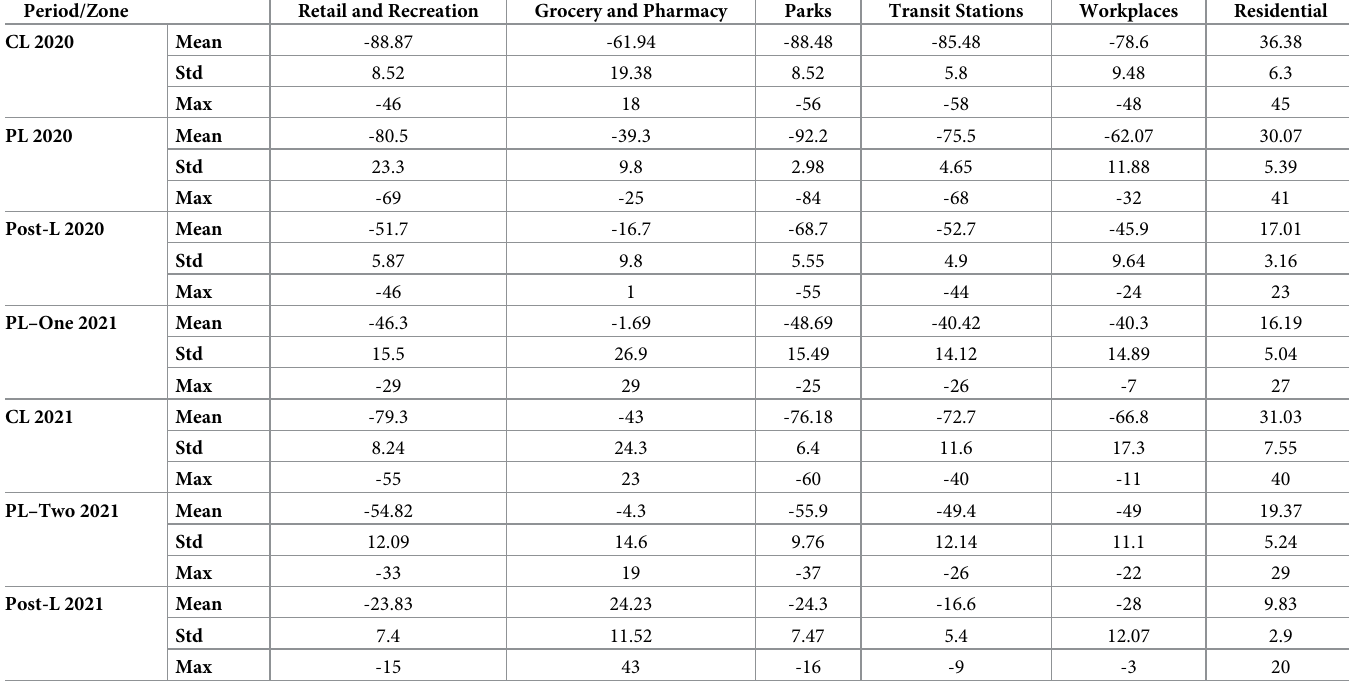
Table 2. Descriptive statistics of the changes in mobility (in %) from baseline during various lockdown phases in both waves in Chennai in the six spheres of activity. Period/Zone